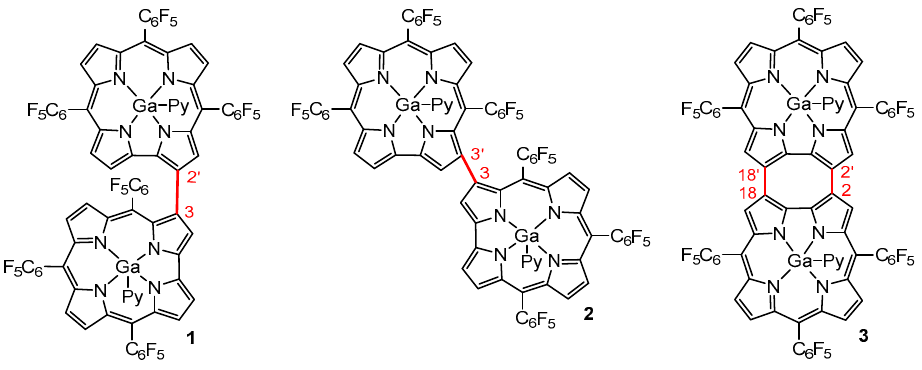
Figure 1. Chemical structure of singly ( 1 and 2 ) and doubly linked ( 3 ) corrole Figure 31. Chemical structure of singly ( 1 and 2 ) and doubly linked ( 3 ) corrole dimers.